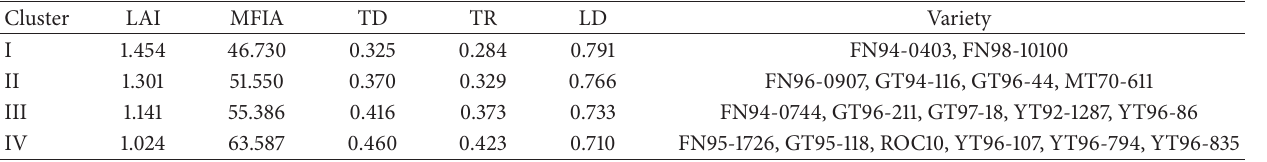
Table 5: Difference in different canopy parameters among 17 sugarcane varieties.